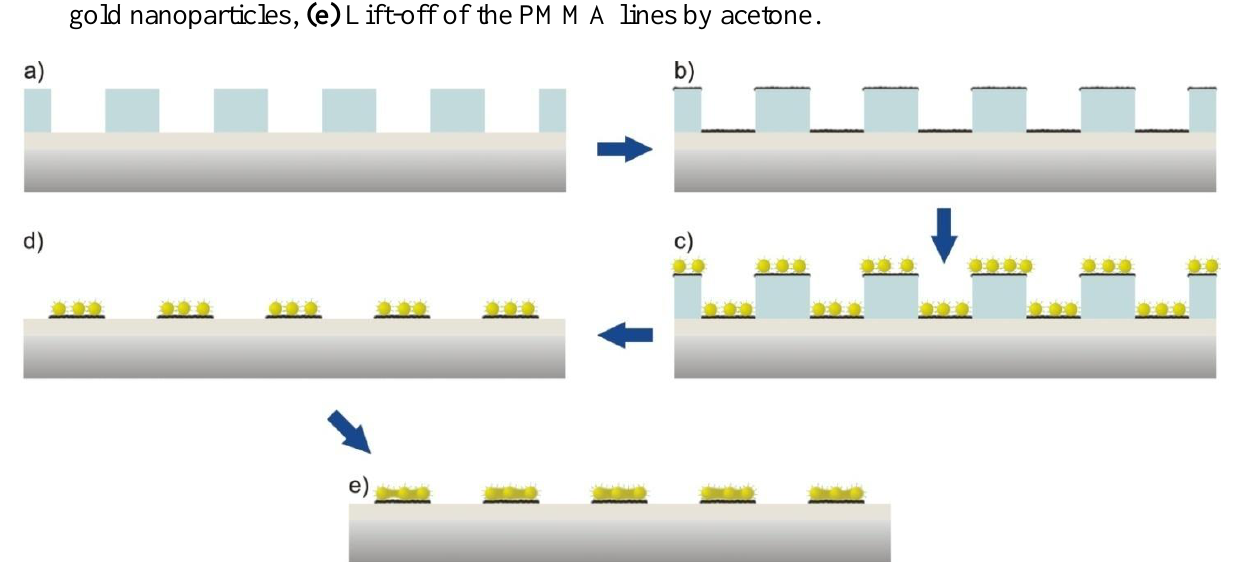
Figure A2. (a) PMMA line pattern fabricated by EUV-IL, (b) Adsorption of PEI, (c) Adsorption of gold nanoparticles to the PEI layer, (d) Chemical enhancement of the gold nanoparticles, (e) Lift-off of the PMMA lines by